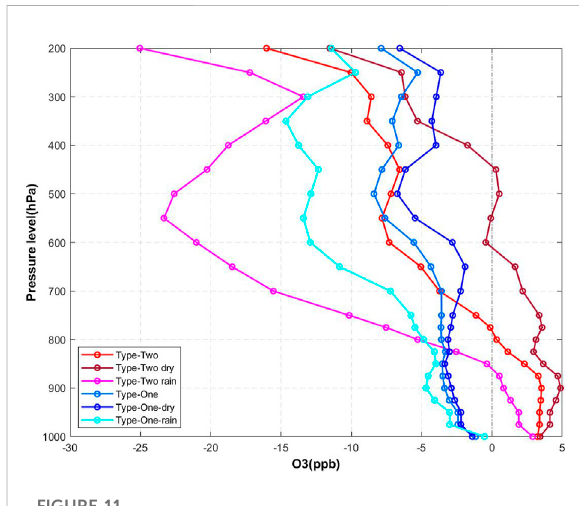
FIGURE 11 Vertical pro fi le of the O 3 mass mixing ratio in Shanghai in autumn. The horizontal axis is the anomalies. Data source: